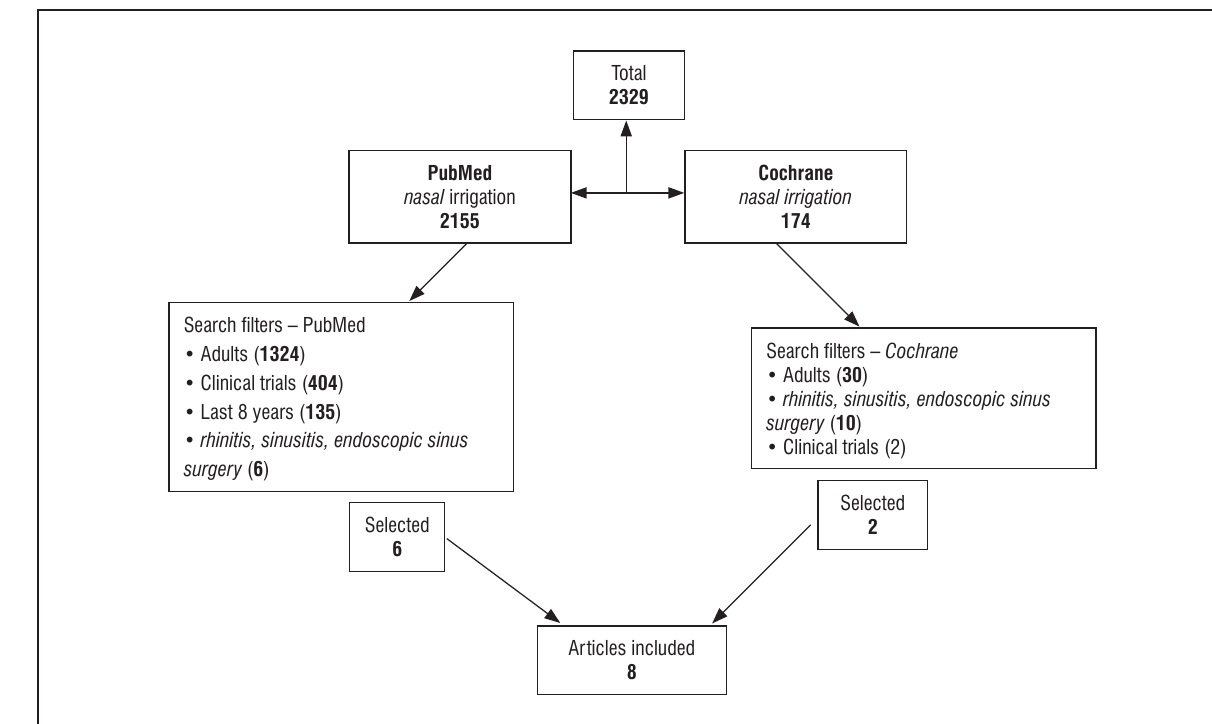
Figure 1 - Flow chart depicting the search and article selection.